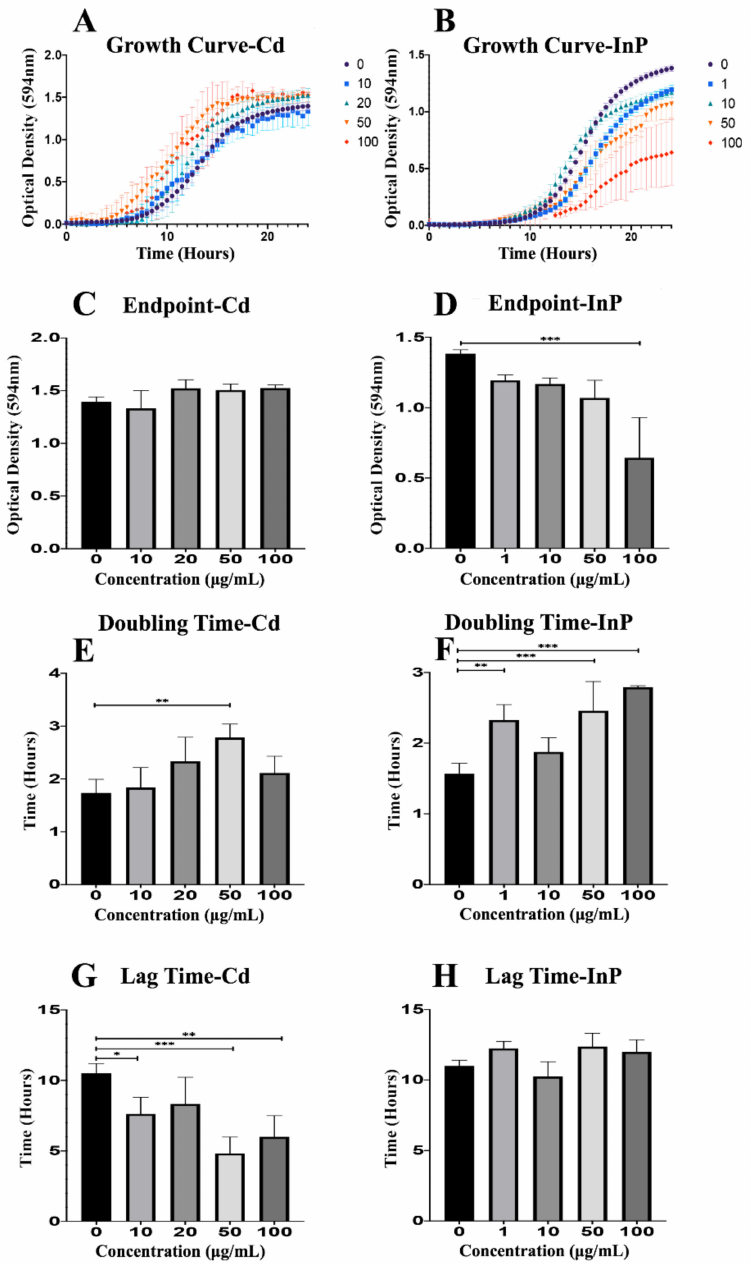
Figure 1. Growth assay to determine growth rates of CdSe/ZnS and InP/ZnS-treated yeast cells. ( A , B ) Quantification of cell optical densities over a 24-h period where the cells are treated with CdSe/ZnS and InP/ZnS quantom dots (QDs), respectively, at 30 ◦ C while shaking. ( C , D ) Measure- ment of cell optical densities at 24 h of treatment with CdSe/ZnS and InP/ZnS QDs, respectively. The bar representing the average optical densities (ODs) (594 nm) of each concentration at the 24-h mark. ( E , F ) Doubling time takes place during the phase of exponential growth for the cells treated with CdSe/ZnS and InP/ZnS QDs, respectively, and was measured as the amount of time it takes for cells to double their ODs. ( G , H ) The mean lag time before the exponential growth phase. Significant statistical differences are represented with *( p < 0.05), **( p < 0.01), and ***( p <